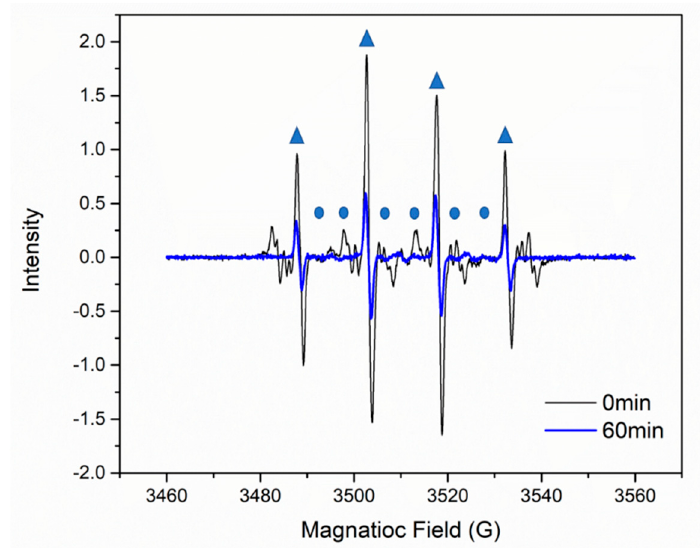
Figure 9. The electron paramagnetic resonance (EPR) spectra of the PS/M-150 system with DMPO (5, 5-Dimethyl-1-pyrroline-N-oxide) as a trapping agent. DMPO-OH· adduct; DMPO-SO 4 − · adduct; Experimental conditions: (PS) = 15 mmol L − 1 , M-150 dosage = 0.1 g L − 1 , (DMPO) = 0.9 mol L − 1 , (X-3B) = 100 mg L − 1 , T = 25 °C .